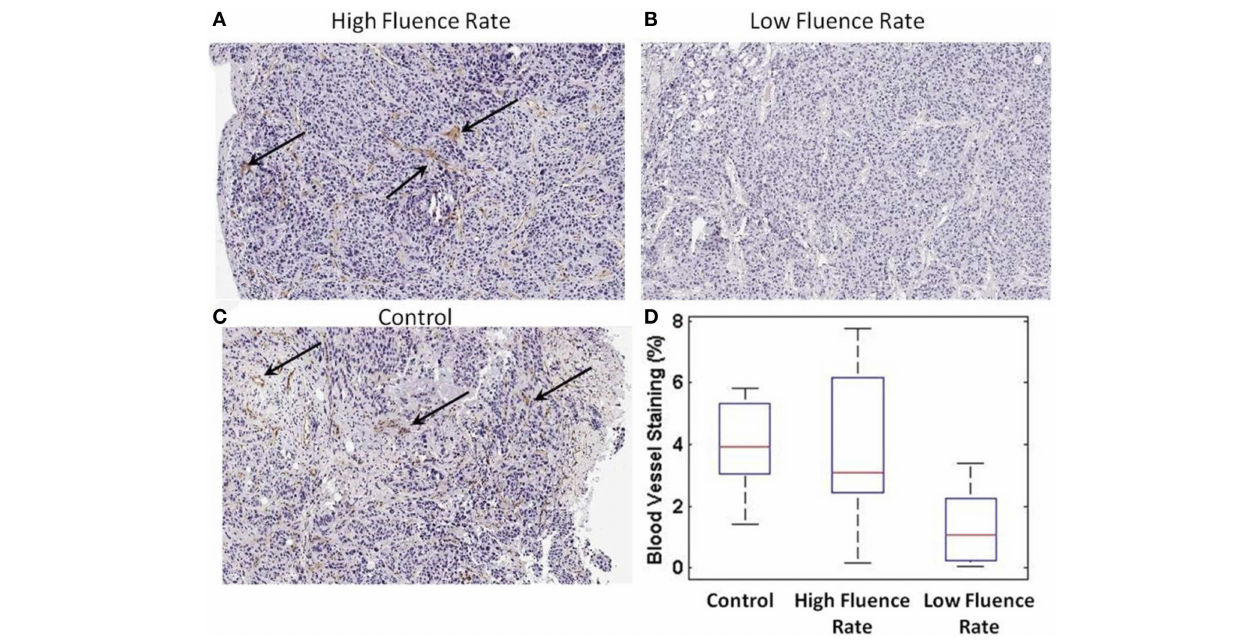
FIGURE 7 | CD31 microvessel staining post-PDT. (A) CD31 staining from a high-fluence-rate treated mouse (B) low-fluence-rate treated mouse (C) control mouse. The black arrows highlight regions of staining. (D) Quantitative bar plot representation of the CD31 microvessel staining for each group.